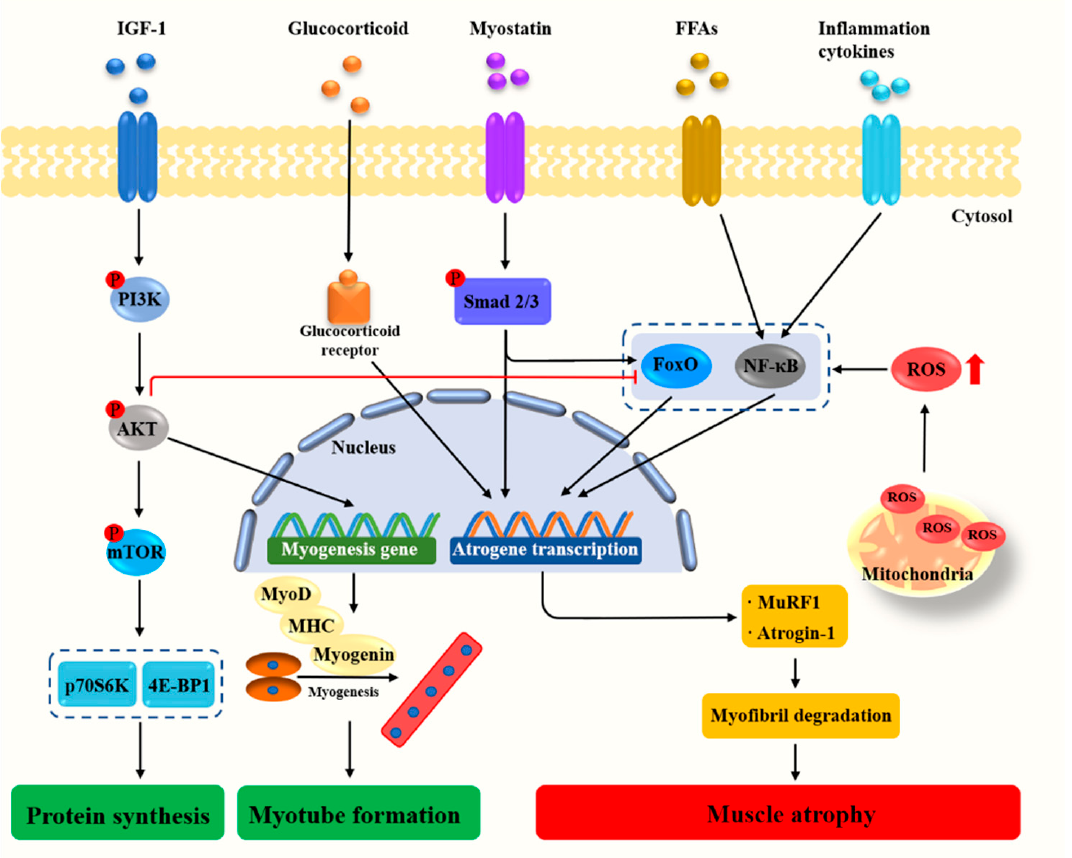
Figure 1. Cellular and molecular mechanisms regulating muscle growth and atrophy. Akt, Protein kinase B; FFAs, Free fatty acids; FoxO, Forkhead box O; IGF-1, Insulin-like growth factor 1; MAFbx, Muscle atrophy F-box; MHC, Myosin heavy chain; mTOR, Mammalian target of rapamycin; MuRF1, Muscle RING-finger protein-1; MyoD, Myogenic differentiation antigen; NF- κ B, Nuclear factor kappa-B; PI3K, Phosphoinositide 3-kinase; P70S6K, Ribosomal protein S6 kinase; ROS, Reactive oxygen species; 4E-BP1, Rapamycin complex and 4E binding protein-1.